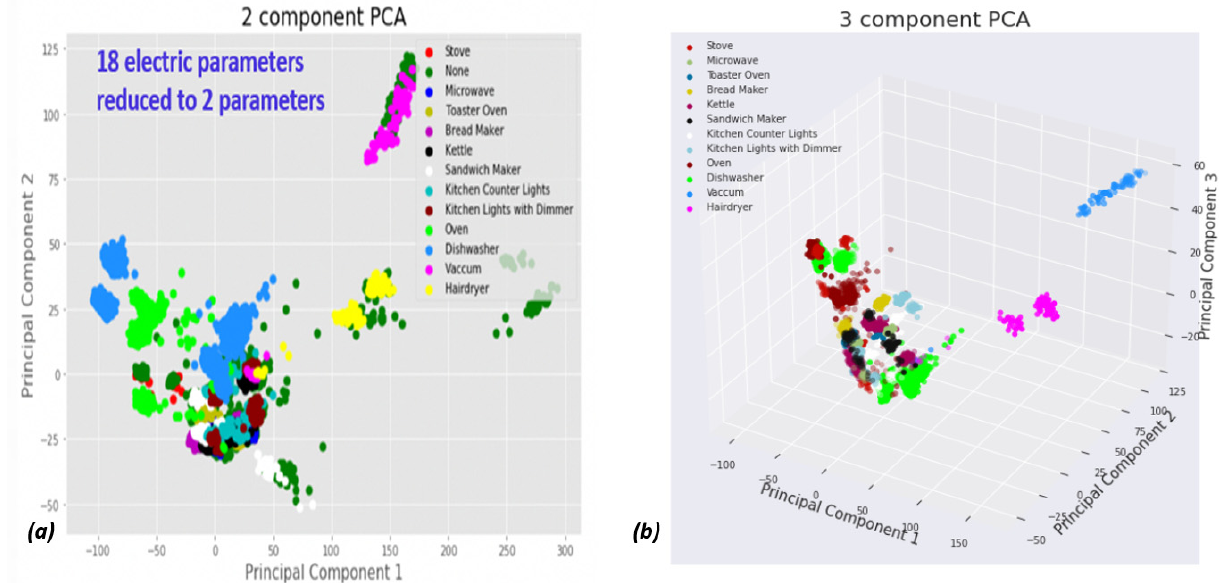
Figure 5. PCA visualization of device spectral projection: ( a ) dimension reduction to 2D; ( b ) dimension reduction to 3D. The two-fold 2D and 3D reductions verify that even after high-order space feature construction, individual “device signatures” are often close to each other. This reinforces the role of high-order space in distancing the device